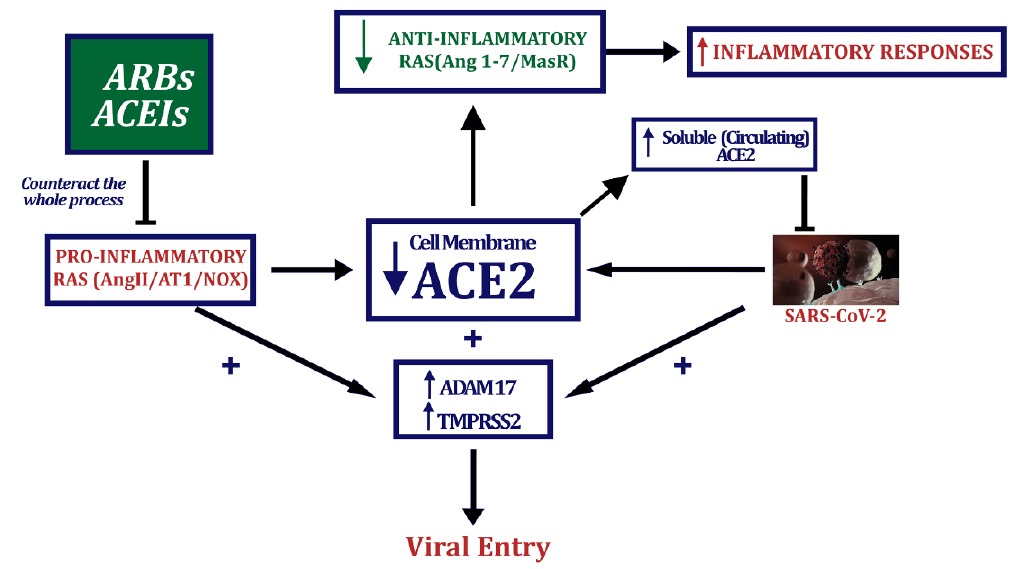
Figure 2. Both SARS-CoV-2 binding to cell membrane ACE2 and activation of the RAS pro-inflammatory arm decrease levels of membrane ACE2 and increase ADAM17 and TMPRSS2 activities. A decrease in transmembrane ACE2 activity leads to a decrease in anti-inflammatory RAS activity. Treatment with ARBs or ACEIs reduces the activity of the pro-inflammatory RAS axis, upregulating ACE2 transmembrane levels and the anti-inflammatory axis activity. Inhibition of the RAS pro-inflammatory axis also inhibits ADAM17 and TMPRSS2 activities, which are necessary for membrane ACE2 shedding and viral entry. Membrane ACE2 shedding further reduces membrane ACE2 and releases circulating soluble ACE2 that may bind/neutralize circulating viruses.